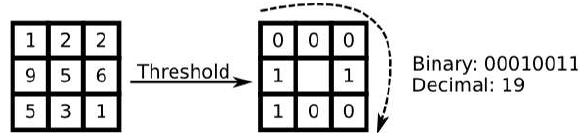
Figure 4. LBP coding scheme on spectro-temporal local